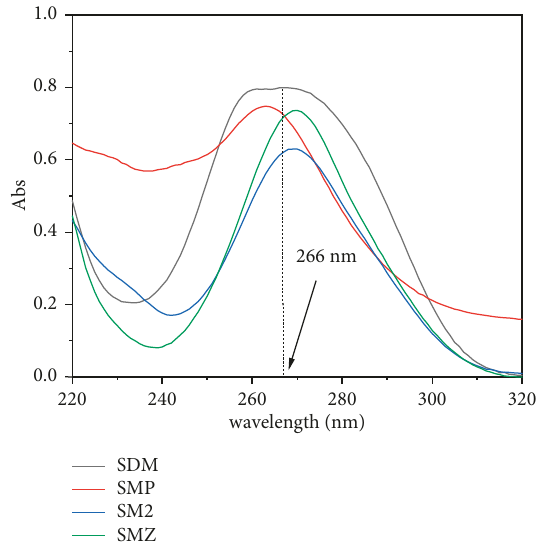
Figure 2: The UV-vis absorption spectra of the four SAs in aqueous